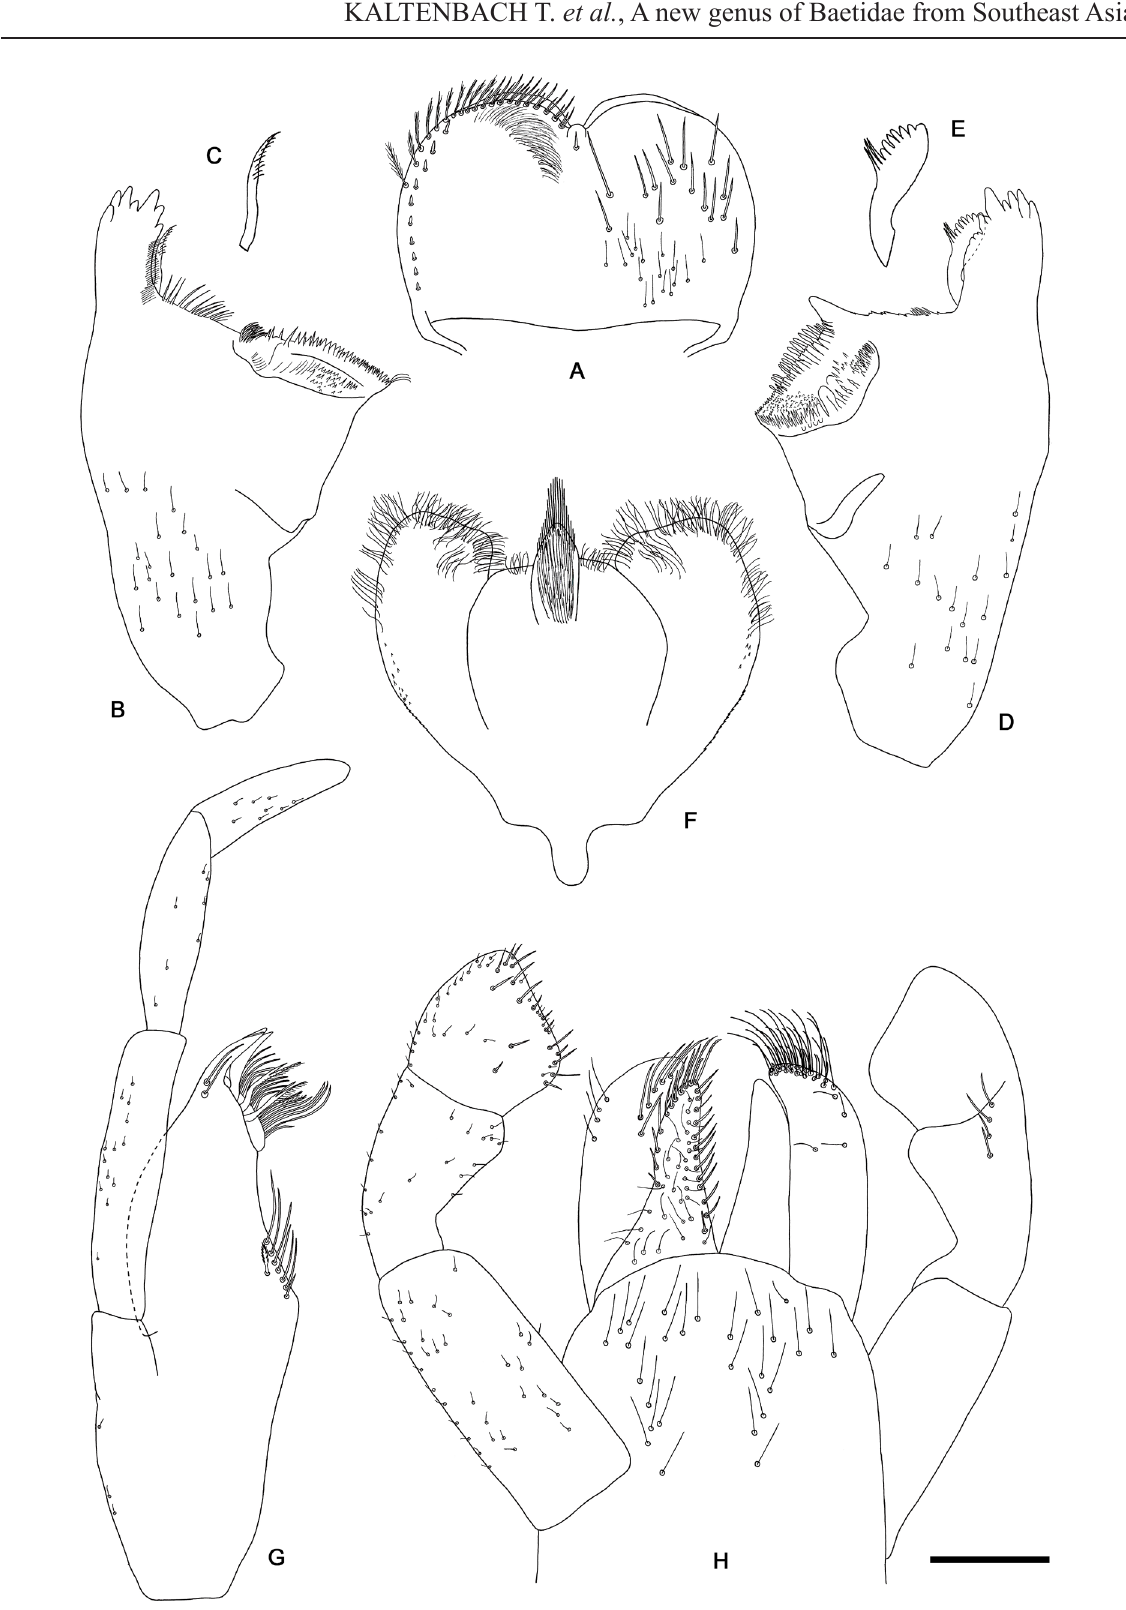
Fig. 1. Procerobaetis leptobranchius gen. et sp. nov., larval morphology. A . Labrum. B . Right mandible. C . Right prostheca. D . Left mandible. E . Left prostheca. F . Hypopharynx. G . Maxilla. H . Labium. Scale bar: 0.1